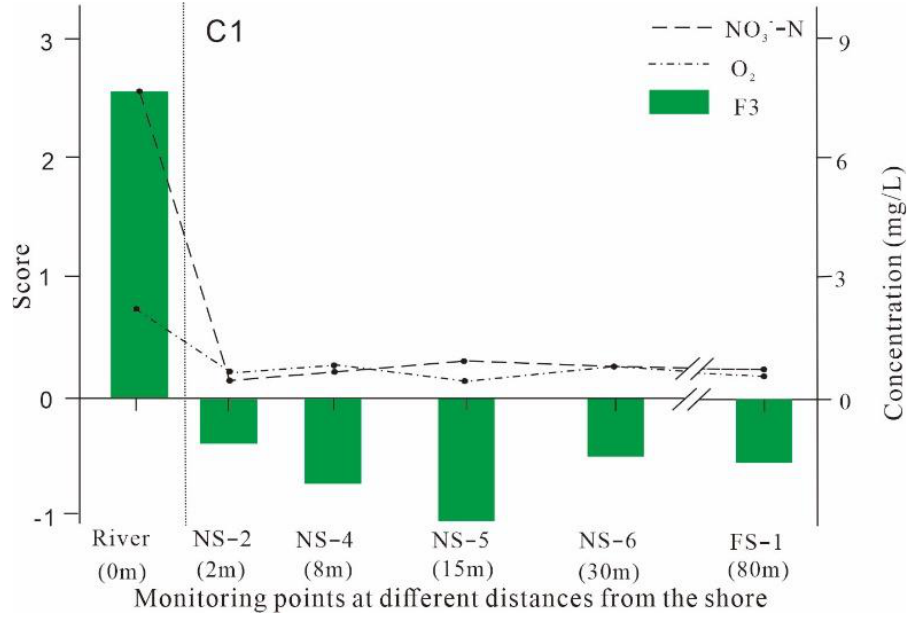
Figure 7. Factor scores and component concentrations in C1.